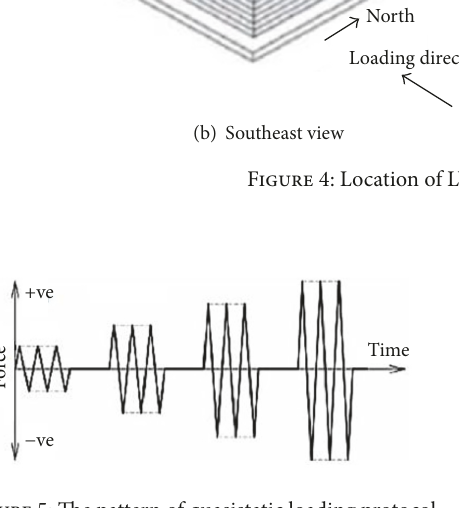
according to the force controlled environment. The test was started from the lateral load of 58.9 kN (6 tons) and it lasted at the load value of 258.96 kN (26 Tons). The load was amplified with an increment of 2 tons in each successive cycle, which makes ten load cycles. During the first